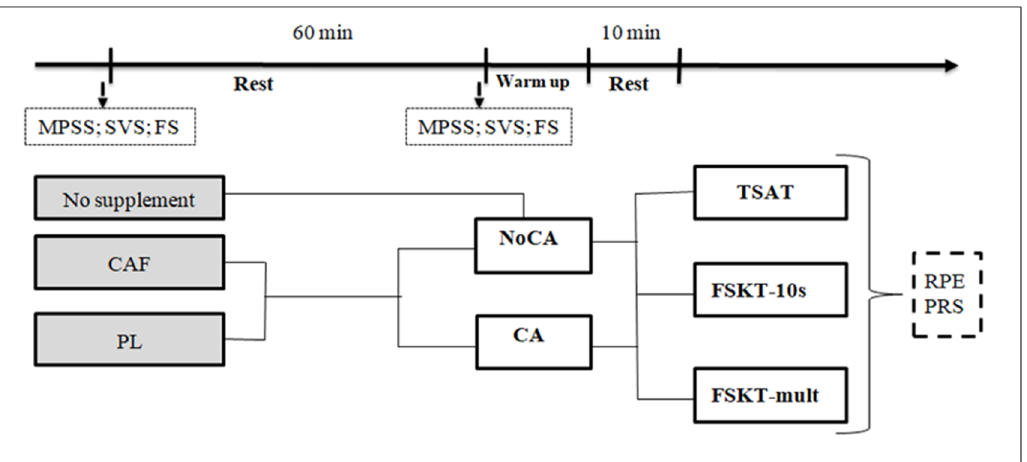
Figure 1. Schematic representation of the study design. MPSS—Mood and Physical Symptoms Scale; SVS—Subjective Vitality Scale; FS—Feeling Scale; RPE—rating of perceived exertion; PRS—perceived recovery status; PL—placebo; CAF—caffeine; CA—conditioning activity; TSAT—taekwondo-specific agility test; FSKT-10s—10 s frequency speed of kick test—FSKT-mult: multiple frequency speed of kick test.